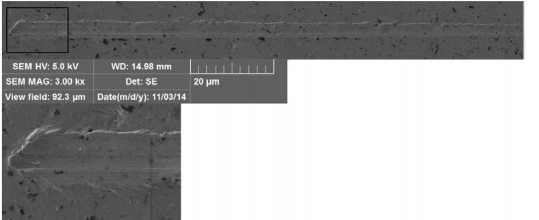
Figure 7. SEM of the 50 mN scratch on the 20 V (1 h) H (1 mol.L -1 ). Image obtained with a magnification of 3000x.